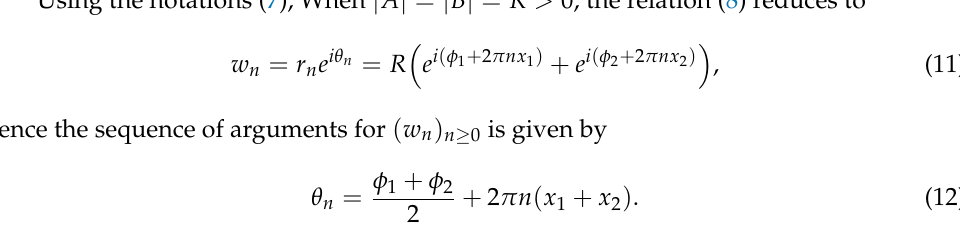
Figure 1. The case when | A | = | B | . Horadam sequence terms ( w n ) N and ( b ) N = 500. We also plot the seeds a , b (stars), generators z 1 , z 2 (squares), unit circle S (solid line), and the circle U ( 0,2 | A | ) (dotted line). In ( a ), the arrows indicate an increase in index n .